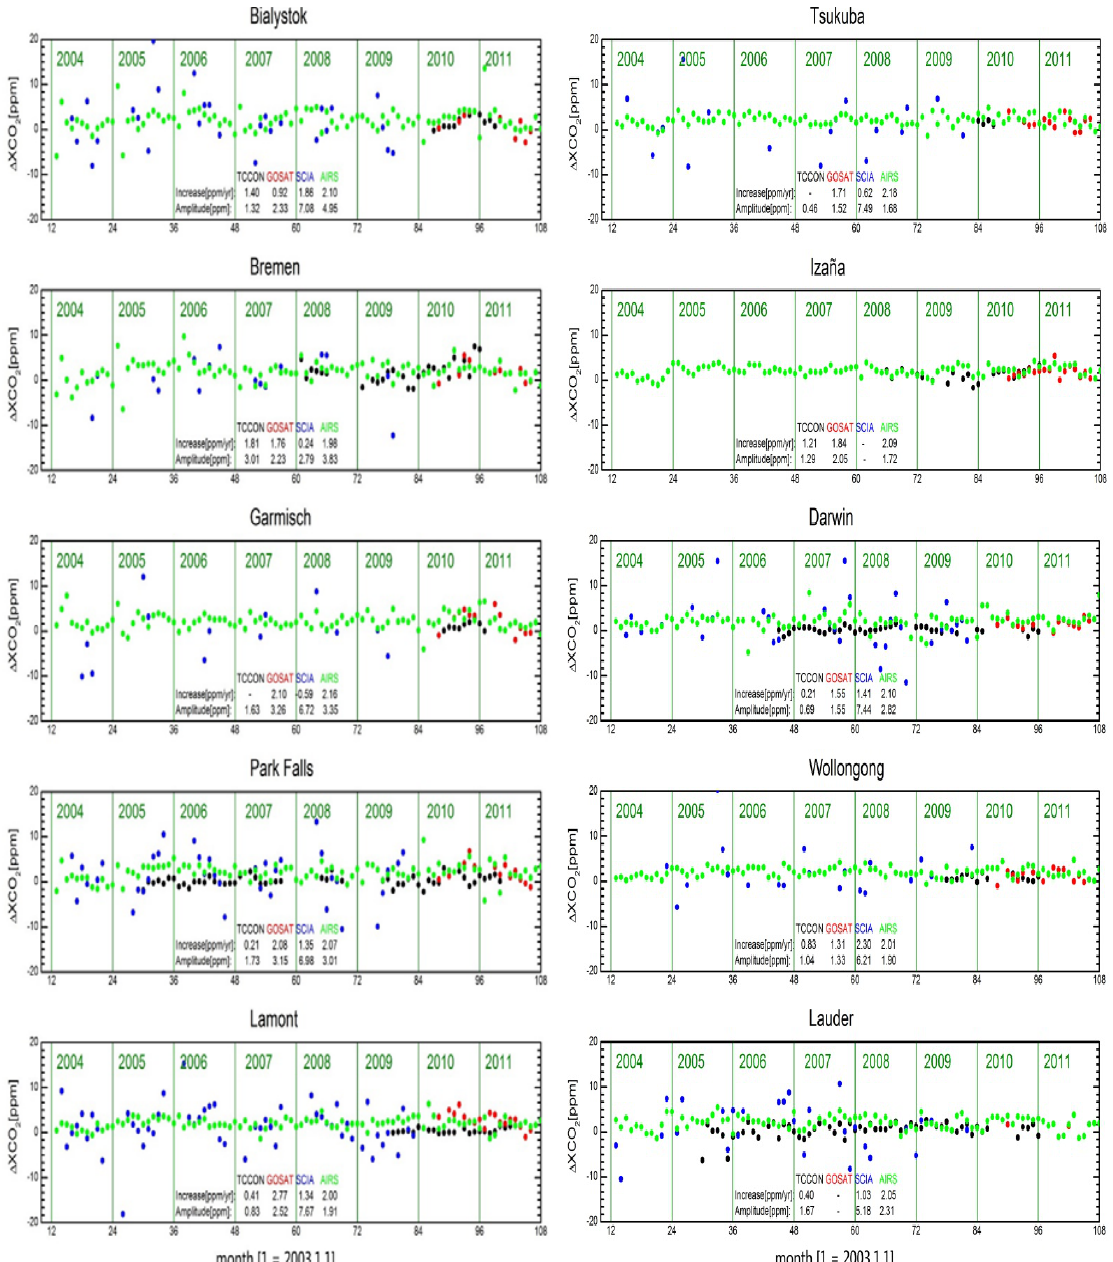
year-to-year linear increasing trends of the satellite product, Figure 6. Time series of XCO 2 GOSAT (red), SCIAMACHY (blue), AIRS (green) and g-b FTS (black), at selected TCCON